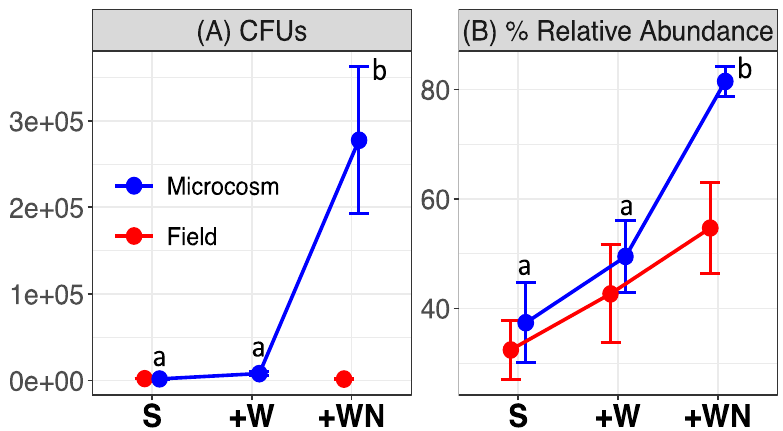
Figure 3. Mean ( ± SE) of the ( A ) number of colony-forming units per gram of dry soil of N. friedmannii and ( B ) relative abundance of N. friedmannii among the treatments in the microcosms (after first water addition and first water + nutrient addition) and in the field (samples collected 6 days after water and water + nutrient additions). The number of colony-forming units and the relative abundance of N. friedmannii increased significantly in the water + nutrient treatment in the microcosms (Tukey’s honestly significant difference (HSD) p < 0.05). In the field experiment, relative abundance increased slightly but not significantly in the +WN treatment (paired t -test p = 0.12), while colony-forming units did not increase significantly (paired t -test p = 0.33). S = starting soil (control), +W = water addition (only the first water addition in microcosms), +WN = water and nutrient addition (only the first water addition in microcosms). Note the difference in the y -axis scale between the two panels.